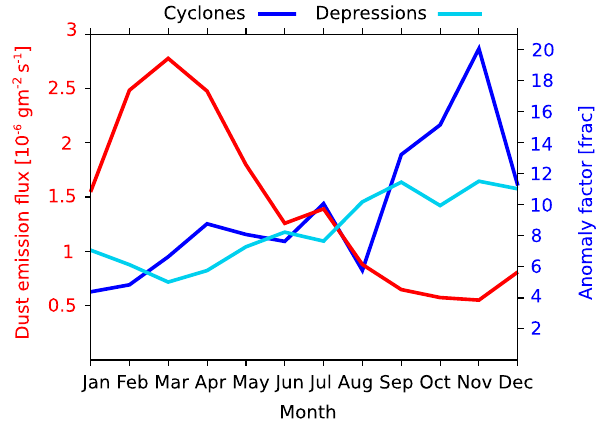
Figure 17. Intensity of dust emission fluxes associated with long- lived, migrating cyclones and atmospheric depressions. Annual cy- cle of the dust emission flux associated with cyclones (red) and the anomaly factor of cyclones (blue) and depressions (cyan) averaged over dust-emitting grid boxes for 1989–2008. The anomaly factor is a measure of emission intensity and defined as the quotient of the dust emission flux associated with the cyclone/depression and the 20-year mean of the dust emission flux of the same